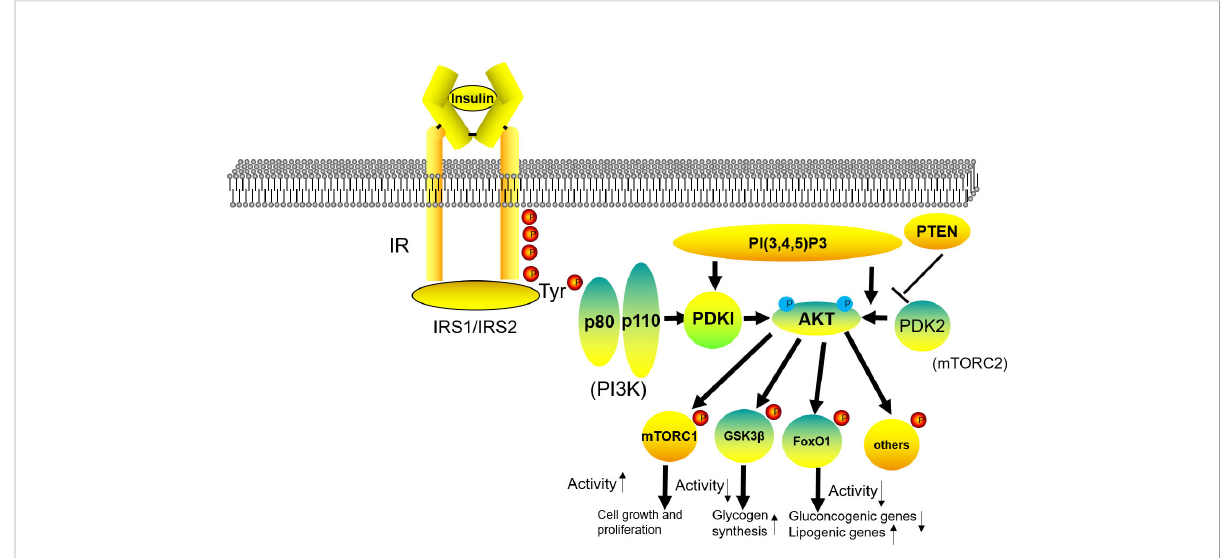
FIGURE 10 Pharmacological mechanisms of CRPR in the IRS1/PI3K/AKT signaling